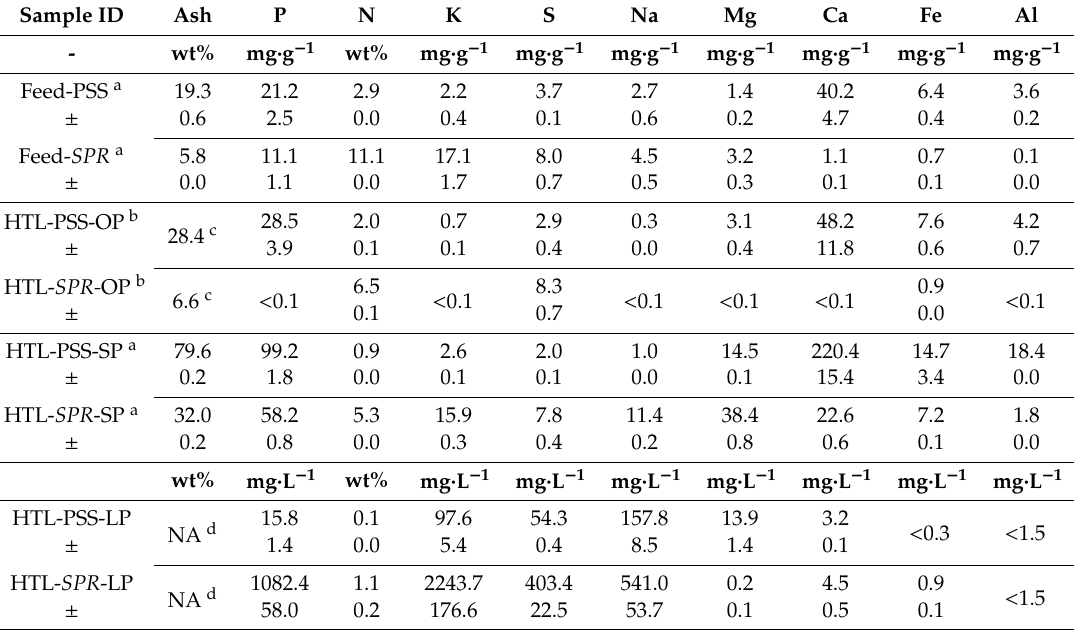
Table 1. Nutrient distribution in feedstocks and between hydrothermal liquefaction (HTL) products (mean value (MV) ± standard deviation (SD) of two